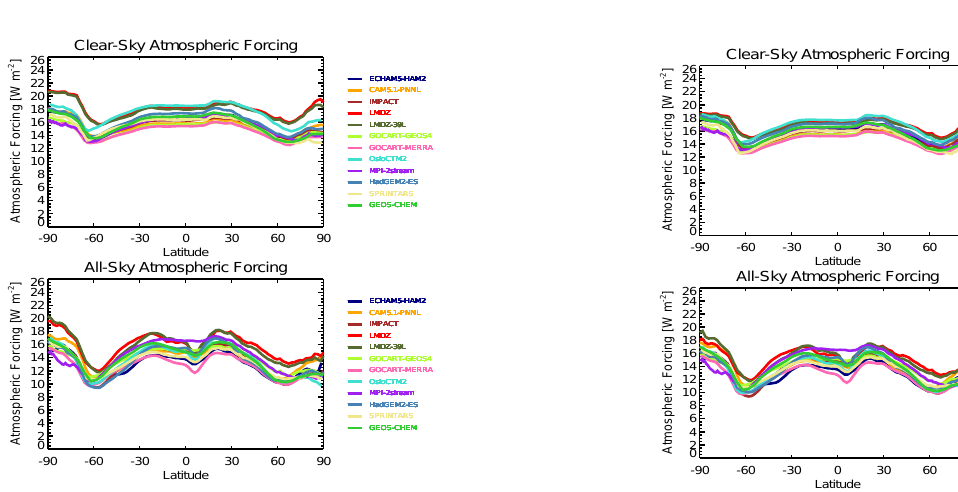
Fig. A8. Annual zonal-mean short-wave all-sky atmospheric radiative forcing (absorption) between experiments with SSA=0.8 and SSA=1.0 with holding ANG=1.0 constant (FIX3-FIX2).